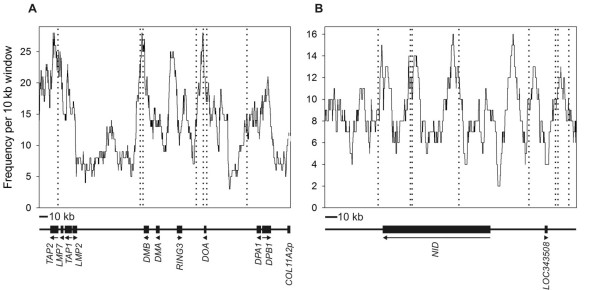
Densities of high GC-content PPTs relative to human hot spot locations. Sliding window plots of the densities of PPTs of at least 12 bp, with GC-contents above the mean for PPTs over the regions we investigated, relative to hot spot locations in A): a 292 kb region of the human MHC Class II region in which 7 hot spots are known and B): a 206 kb region of human chromosome 1 in which 8 hot spots are known. Vertical dotted lines represent hot spot mid point locations. Sliding windows were 10 kb wide and moved in steps of 100 bp. Locations of genes in the regions are shown below the plots with arrows indicating direction of transcription.